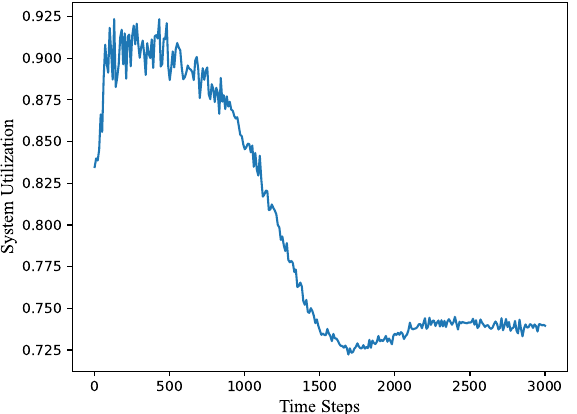
Figure 4. The variation of the system utilization depending on the calculation time steps. As for the system coverage rate, Figure 5 presents its variation as a function of the calculation time steps. It can be observed that the coverage rate was only 0.1 at the beginning. At 0–500 steps, the coverage rate slightly decreases and then increases. It means that the deployment range of nodes tends to expand and then shrink at the first 500 steps. After 500 steps, all nodes continue to shrink regularly. After 1700 steps, when the utilization rate and the moving distance begin to stabilize, the coverage rate begin to rise slowly. It suggests that our 3D algorithm still has a small-scale adjustment process to obtain a better network structure. Finally, the coverage rate reaches around 0.6 while the whole network has a high utilization.